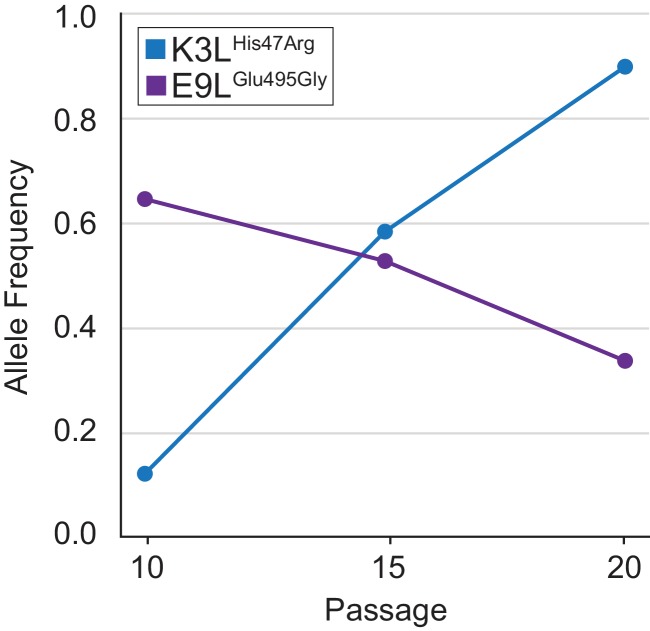
Allele frequencies of the two high-frequency SNVs identified in vaccinia populations.Population-level K3LHis47Arg and E9LGlu495Gly allele frequencies were estimated using freebayes on Illumina MiSeq reads from different passages.10.7554/eLife.35453.011Figure 1—figure supplement 2—source data 3.Data used to generate Figure 1—figure supplement 2.